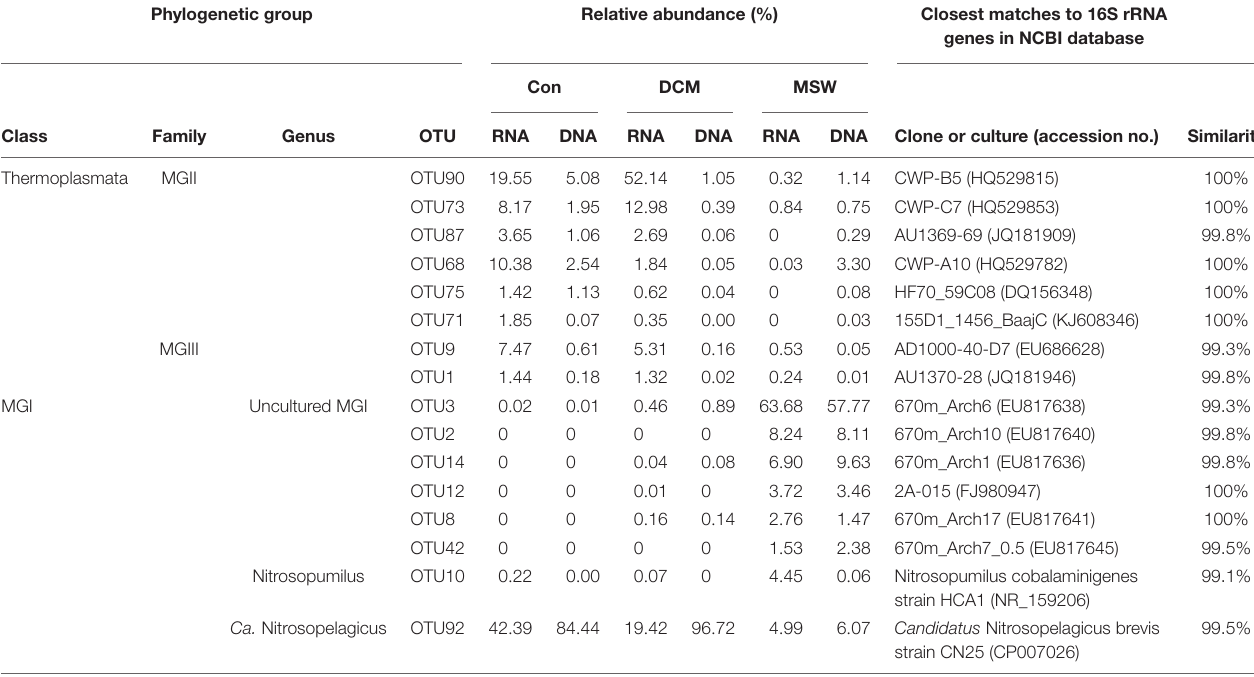
Two DNA parallel averages were used to calculate the relative abundance values in the table. in DCM, but only 12.08% in MSW. In contrast, three OTUs (OTU48, 54, and 63) within the WCB cluster dominated in the MSW group, but they are almost absent in Con and DCM ( Table 2 and Supplementary Figure S3 ). Three representative OTUs retrieved from MSW were identical to clones in the same depth (400 m) from different oceans. For example, OTU54